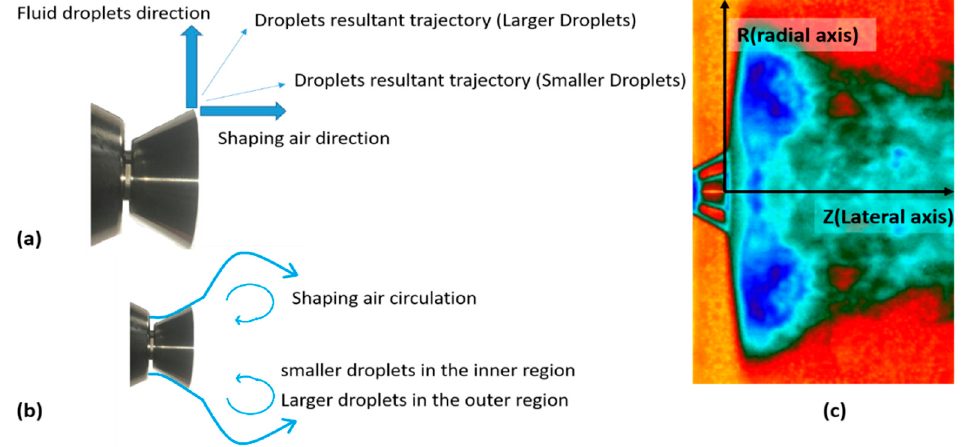
Figure 4. Droplet trajectory within the spray flow field of the rotatory bell atomizer. ( a ) Initial trajectory of the droplet and shaping air while droplets leave the cup [34]. ( b ) The resultant trajectory of air-droplets interaction [34]. ( c ) IR image of rotary bell spray flow field.